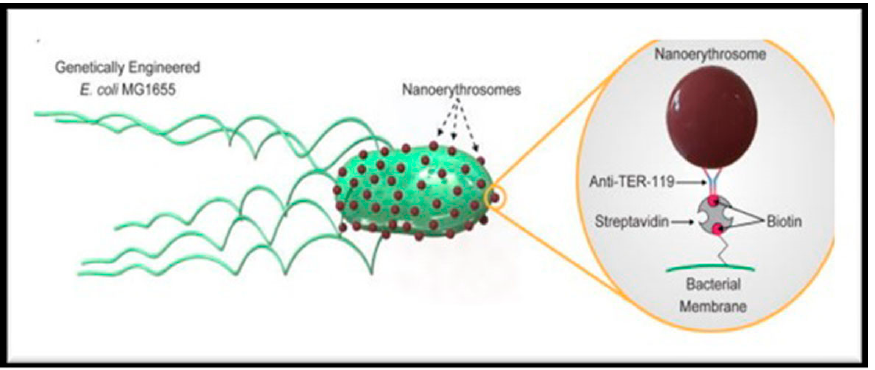
Figure 4. Biohybrid microswimmers using genetically modified E. coli bacterium and NERs for targeted cargo-delivery (Image reproduced from reference [50] which was published under a creative commons attribution (CC BY) license